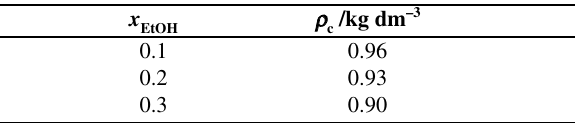
Pe~ar and Gor{ek: Saponification Reaction System: ...